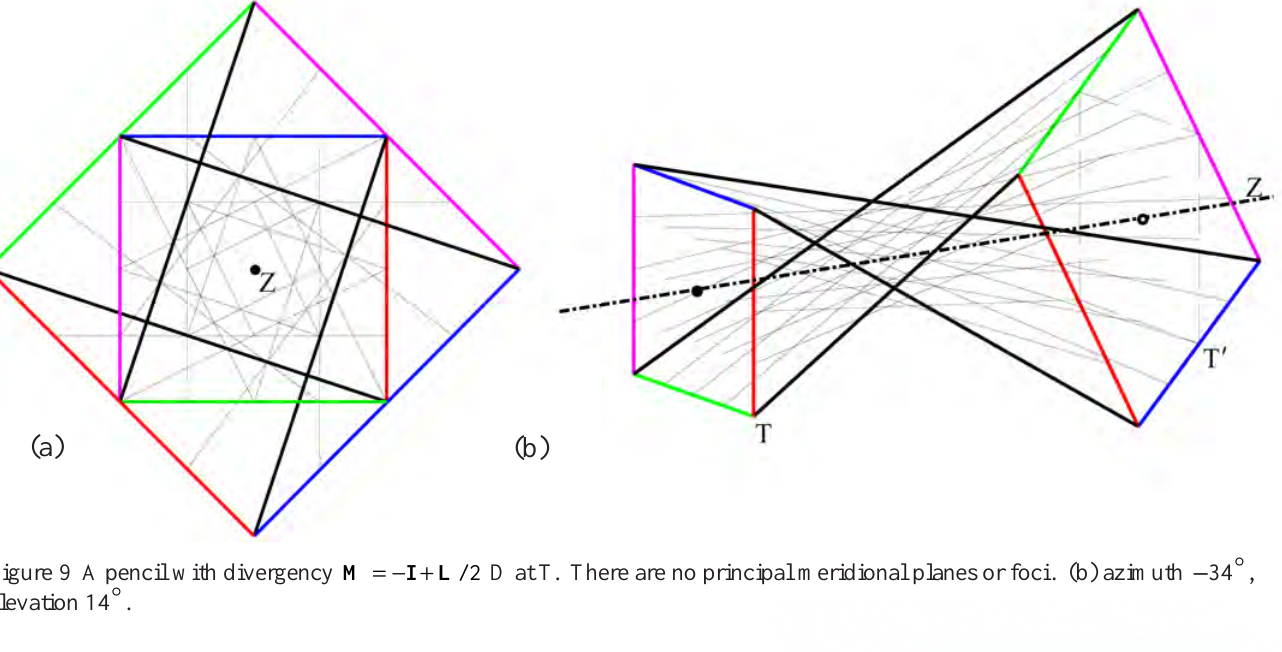
Figure 8 A pencil with divergency 4/ LIM +−= D at T. The addition of the antistigmatic contribution has caused the rays to separate at the point focus in Figure 7. There is no focus and there are no principal meridional planes. (b) azimuth °− 64 34 °− 64 , eleva- tion 14 °− 64 .